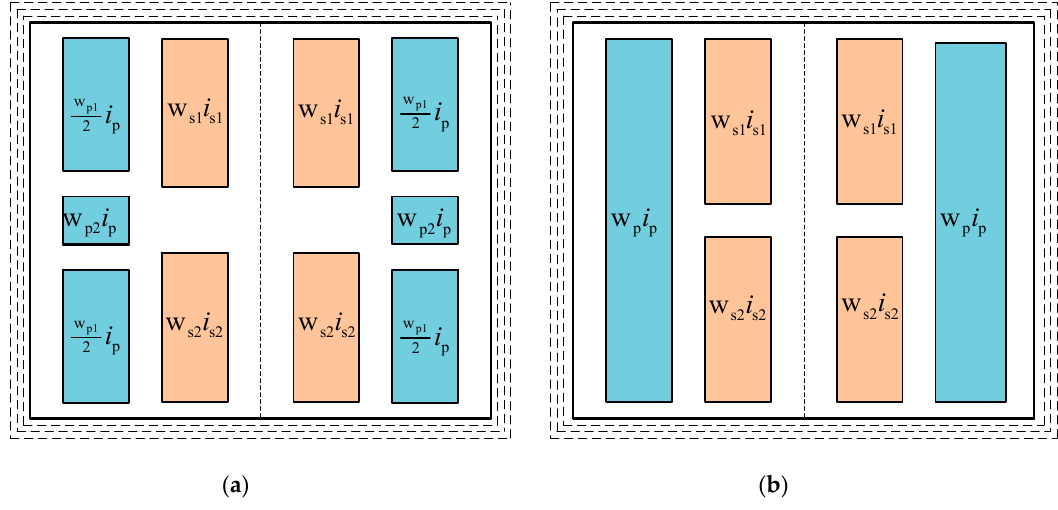
Figure 3. Windings location in rectifier transformers: ( a ) 3/6 phase transformers; ( b ) 3/6 phase transformers for 24 pulses rectifier.